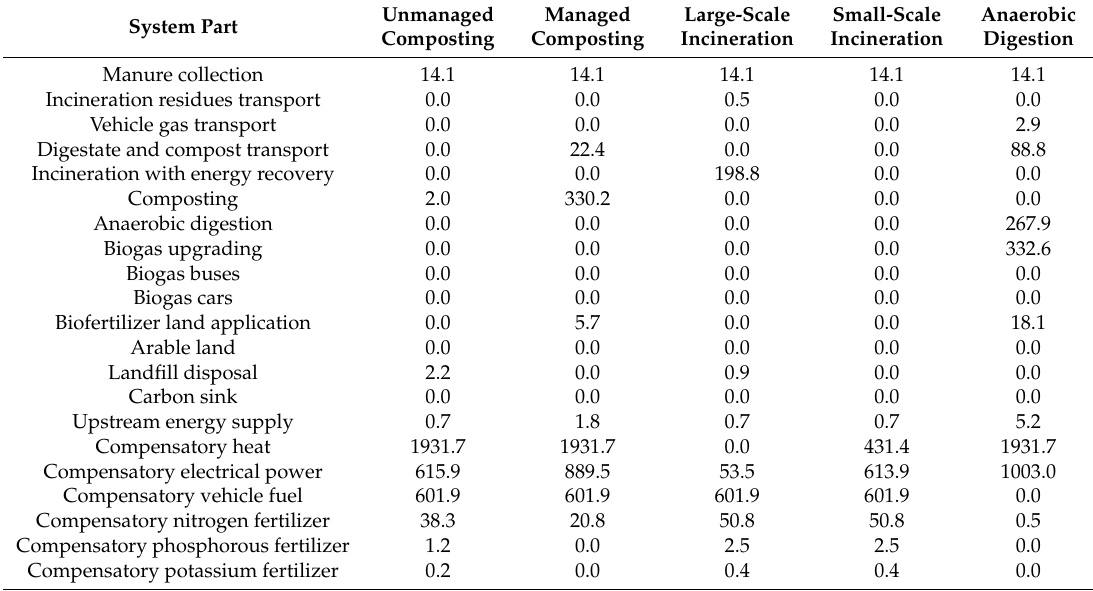
Table B1. Primary Energy Use (MWh).